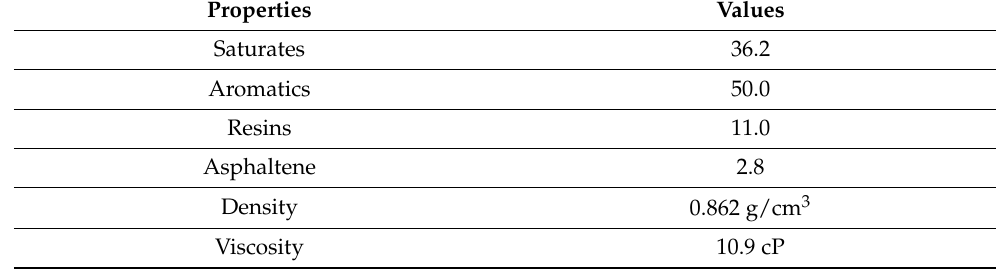
Table 3. Properties of crude oil.